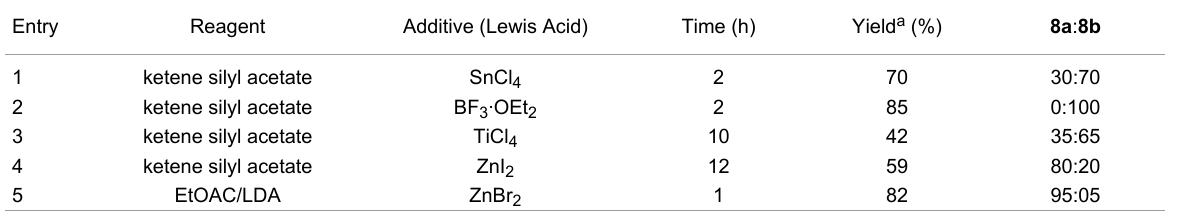
Table 1: Addition reaction under different conditions to obtain 8a and 8b.